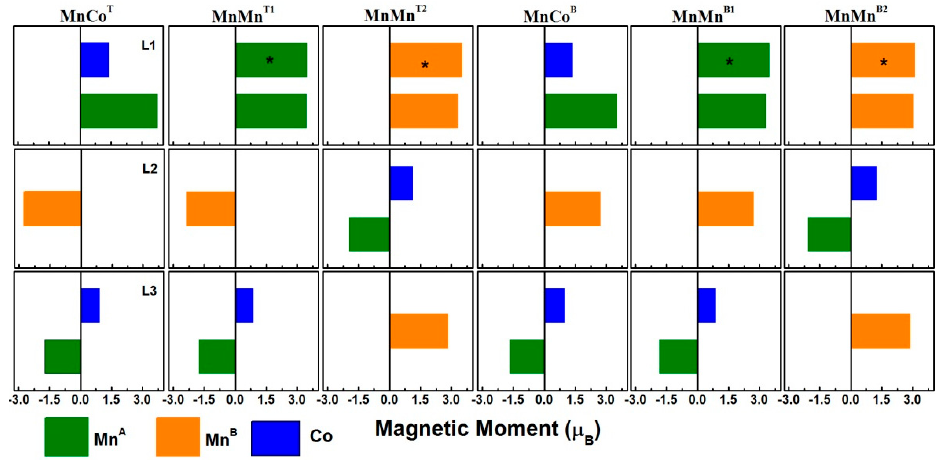
Figure 5. Atom-resolved spin magnetic moment of magnetic atoms of various terminations. L1, L2, and L3 indicate the interface, subinterface, and next subinterface, respectively. The region with ‘*’ stands for the replaced atom.